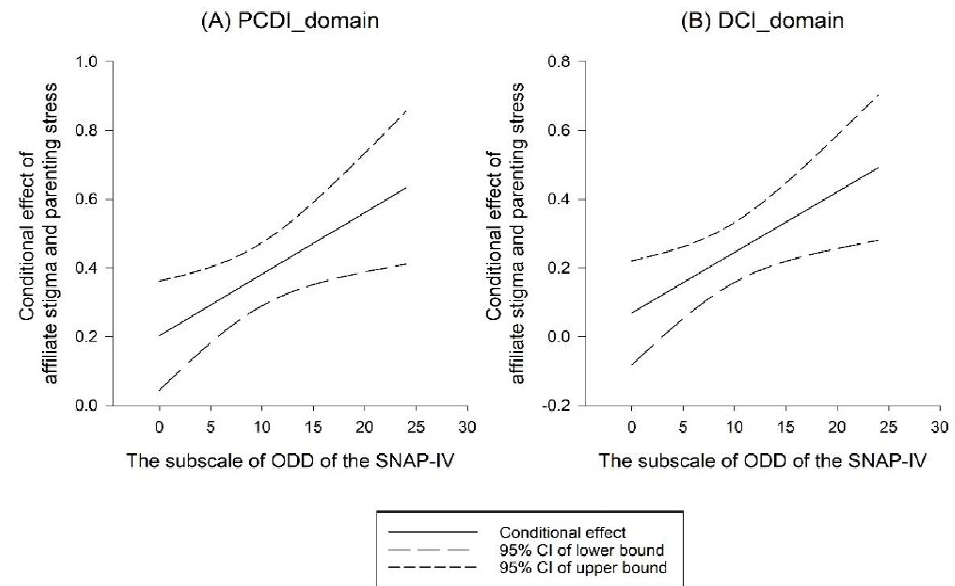
Figure 1. Moderation effects of oppositional defiant disorder (ODD) symptoms on the association between affiliate stigma and parenting stress in caregivers. Mean centering was performed on the predictor (affiliate stigma) and moderator (ODD) symptoms) prior to moderation analysis to enhance comparability.